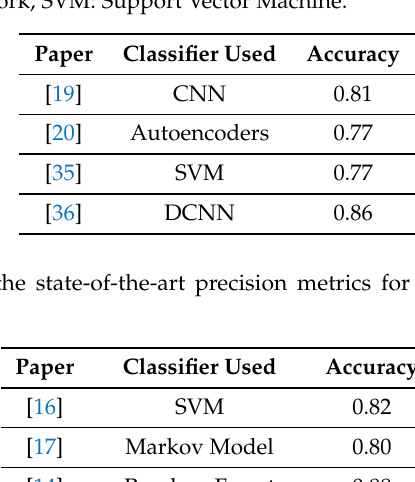
Table 9. A summary of state-of-the-art performance metrics for MR, where DCNN: Dynamic Convolutional Neural Network, SVM: Support Vector Machine.